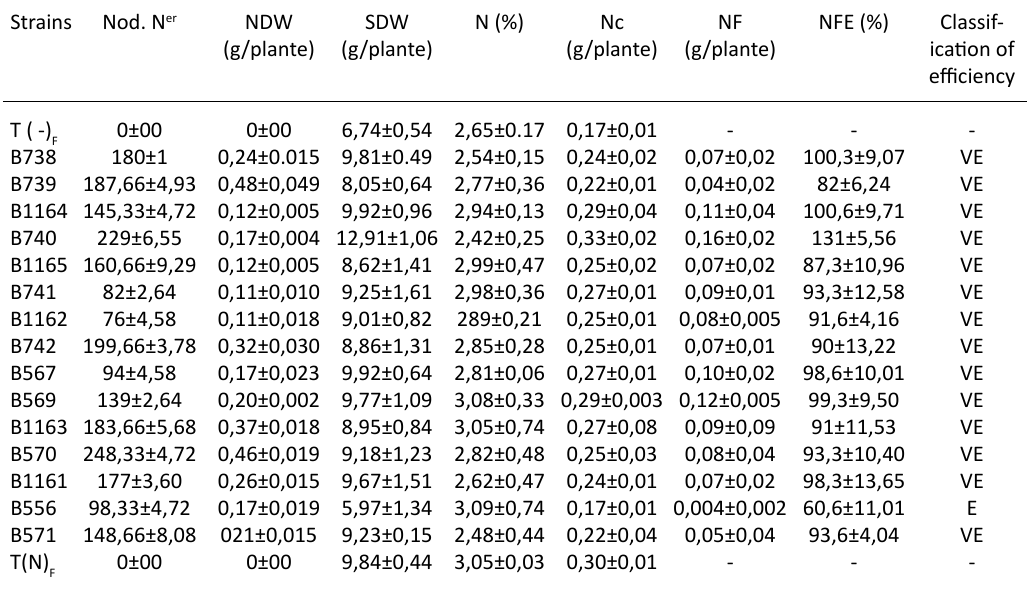
Table 2. Effect of inoculation with different rhizobial strains on bean’s growth, nodulation and nitrogen fixation Strains Nod. N